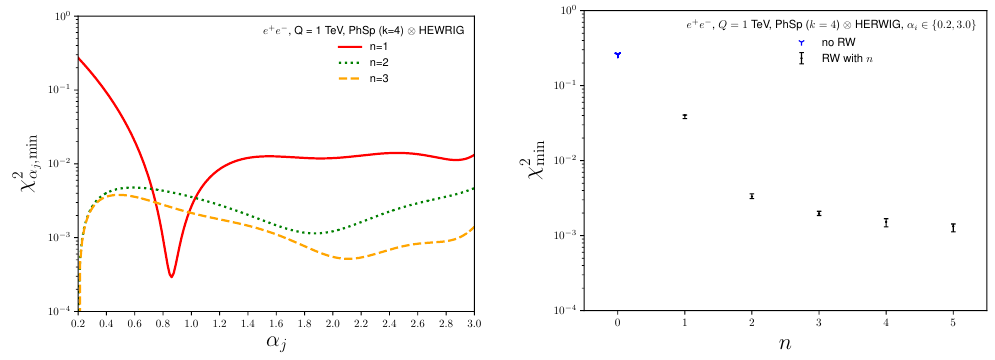
Figure 7 . Left panel: we show the goodness-of-(cid:12)t (cid:31) 2 from eq. (2.3) for the best set of n = 1 (cid:11) j (red), n = 2 (green dotted) and n = 3 (yellow dashed) reweighed angularities as a function of the angularity exponent (cid:11) j for Herwig . For each point we take the median value of the 11 replicas. Right panel: the global minimum (cid:31) 2 from eq. (2.4) for n = 1 ; : : : ; 5. The error bars represent min the uncertainty as described in the text, with the central black dot representing the median over the replicas. The initial value of (cid:31) 2 (blue star) shows how well (cid:13)at phase space reproduces the angularities prior to